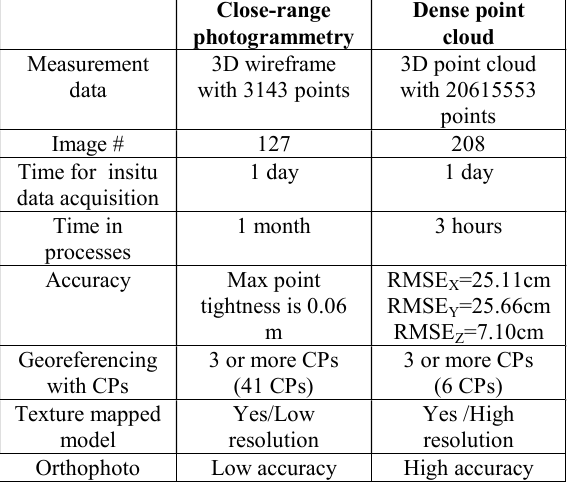
Table 2. Comparison of measurement methods